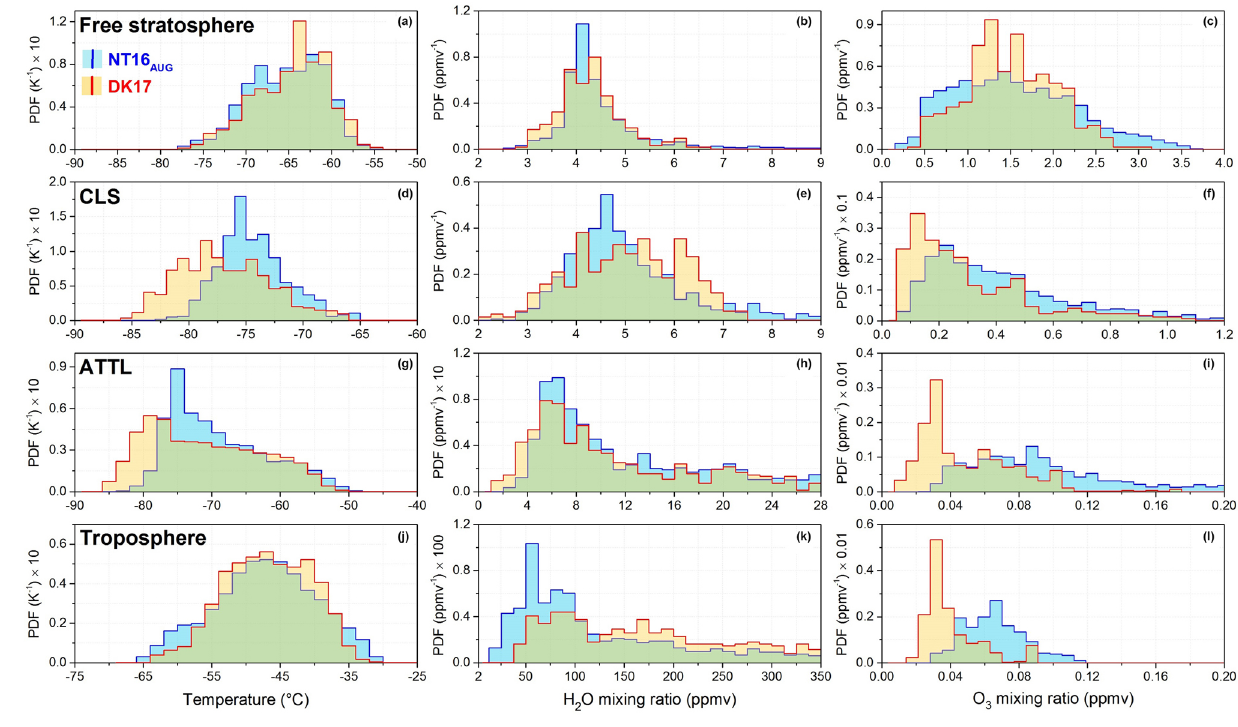
Figure 8. Probability density functions (PDFs) of temperature (a, d, g, j) , the H 2 O mixing ratio (b, e, h, k) and the O 3 mixing ratio (c, f, i, l) , calculated in the free stratosphere (a–c) , CLS (d–f) , ATTL (g, h) and troposphere (j–l) altitude regions as defined in Sect. 5.1, for NT16 AUG (blue) and DK17 (red).